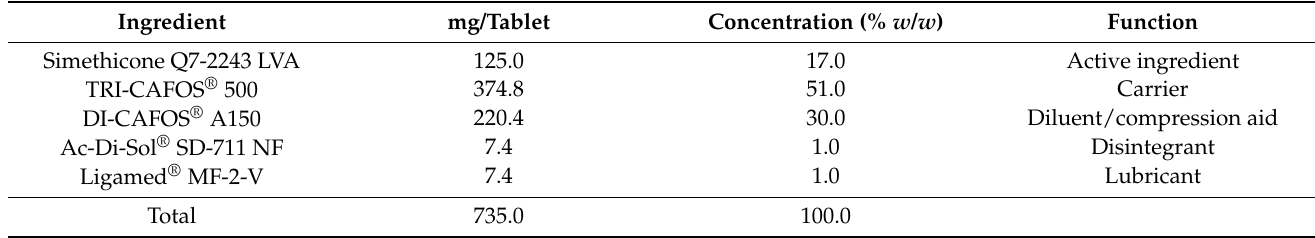
Table 1. Composition of simethicone liquisolid tablets.